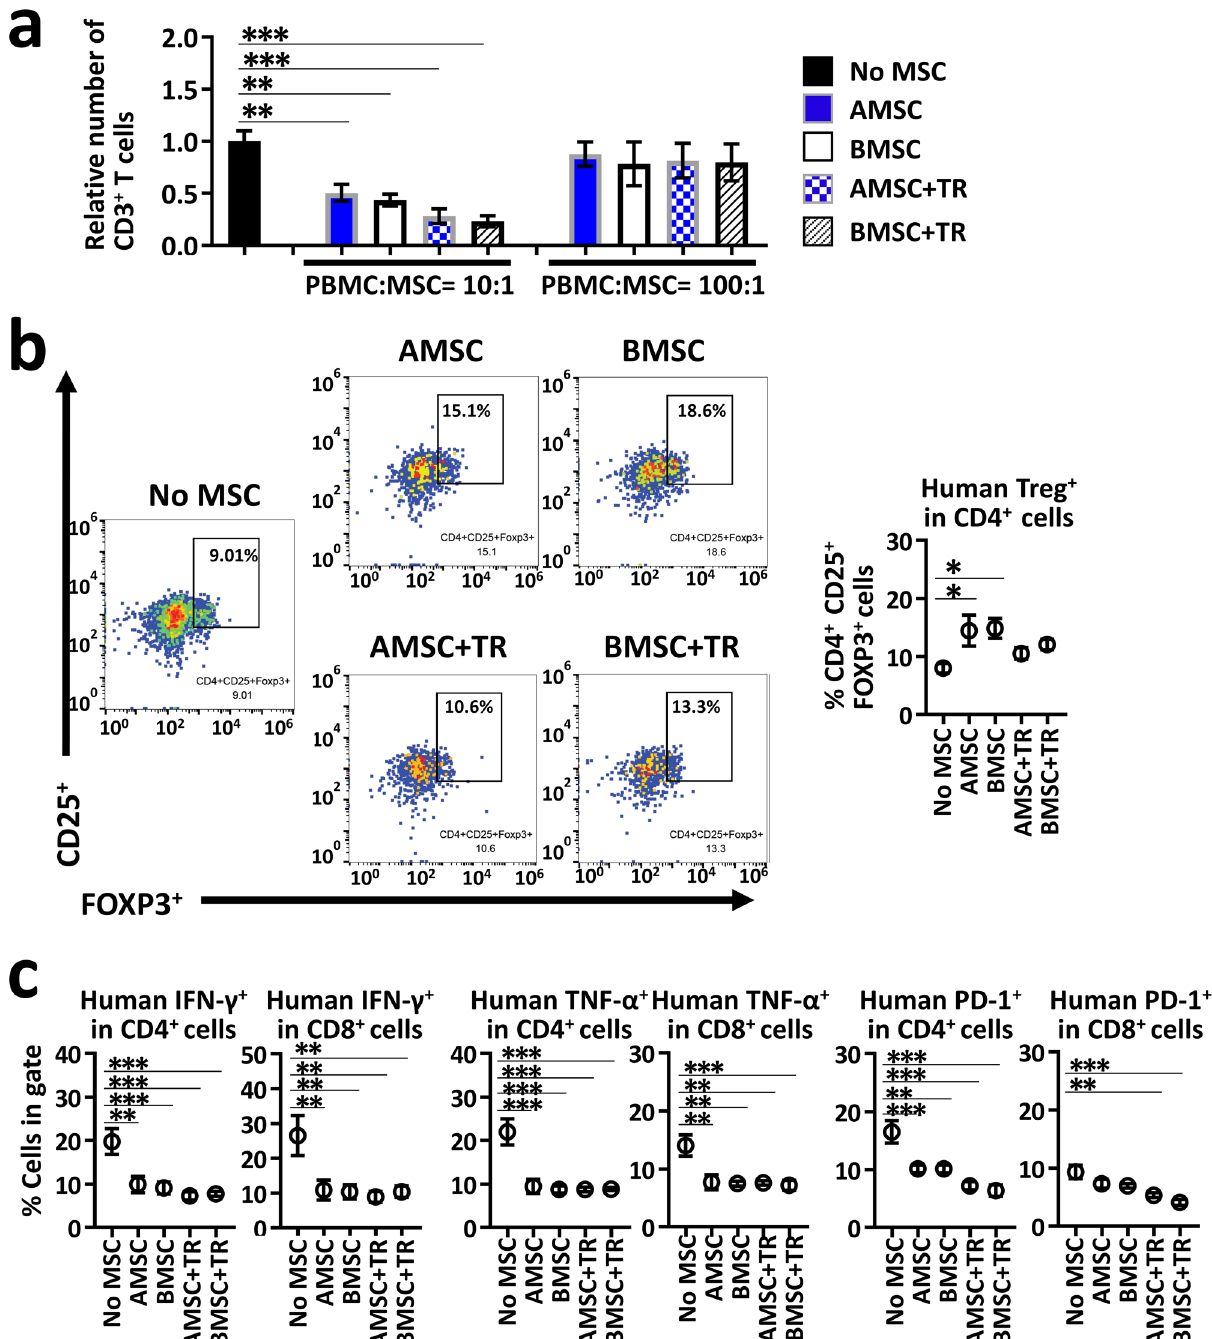
Figure 3. AMSC exert immunomodulatory effects in PHA/IL-2 stimulated PBMC in vitro. PBMC were stimulated with 4 μg/mL PHA and 100 U/mL IL-2 for 72 h with or without AMSC or BMSC at a PBMC/MSC ratio of 10:1 ( a ‒ c ) or 100:1 ( a ). For indirect coculture experiments, a trans well (TR) system comprising upper wells with PBMC and lower wells with MSC was used. Combined data from more than three independent experiments are presented as mean ± SEM. ( a ) Relative number of CD3 + T cells shown as 1 for No MSC. Unstimulated PBMC control showed 0.21 in this assay. ( b , c ) Population of human Treg (CD25 + FOXP3 + ) in CD4 + T cells, and population of human T cells expressing IFN-γ, TNF-α, and PD-1 in human CD4 + or CD8 + T cells analyzed by flow cytometer. Unstimulated PBMC control showed 5.6% Treg, 2.3% IFN-γ + CD4 + , 3.3%